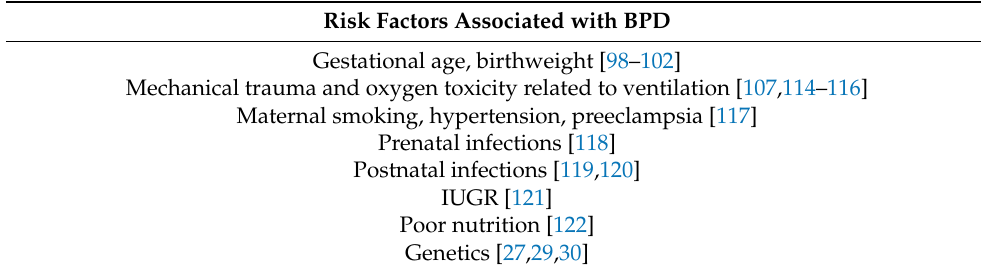
Table 1. Risk factors associated with BPD